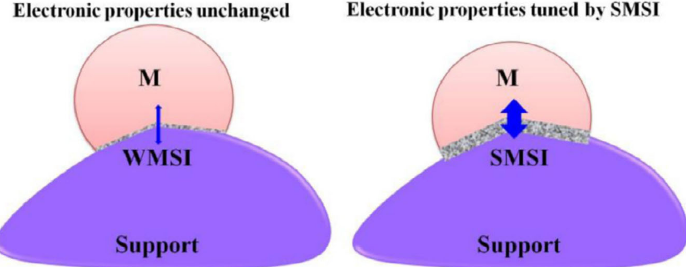
Figure 14. Schematic representation of the main metal–support interactions, namely, weak metal– support interactions (WMSIs) and strong metal–support interactions (SMSIs). Reprinted with permission from Ref. [128]. Copyright 2017 Elsevier.